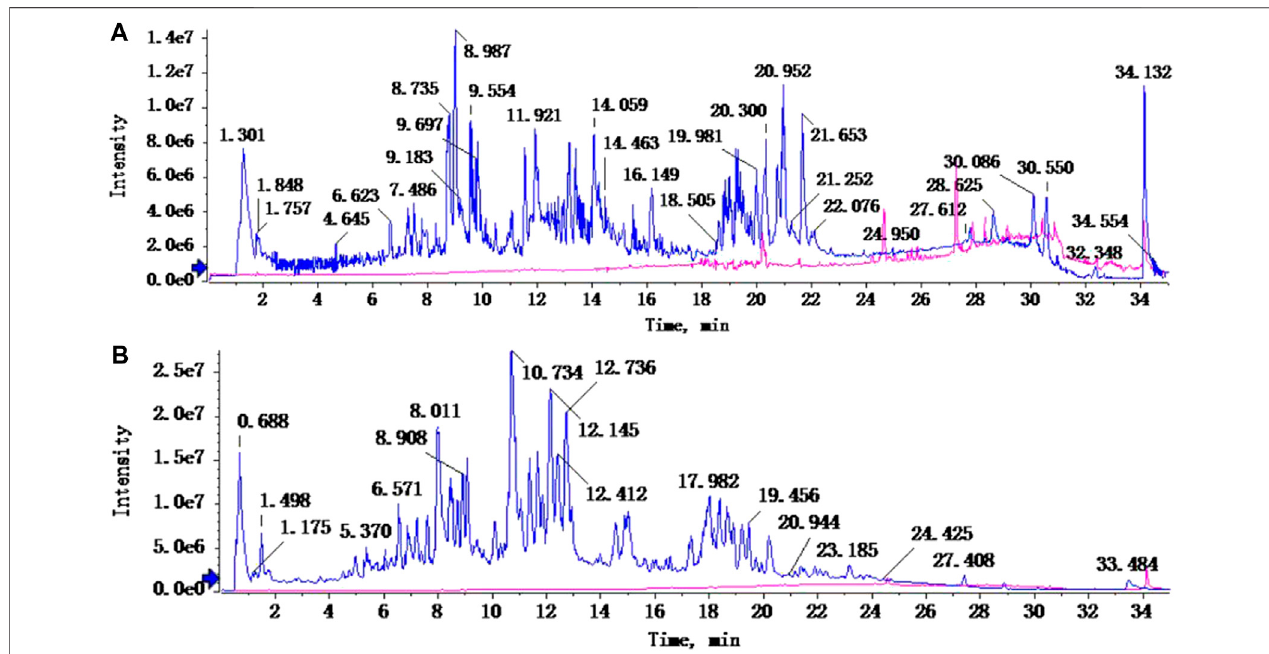
FIGURE 1 | Total ion chromatogram of Scutellaria baicalensis Georgi and Sophora japonica L. under positive ion (A) and negative ion (B) modes.